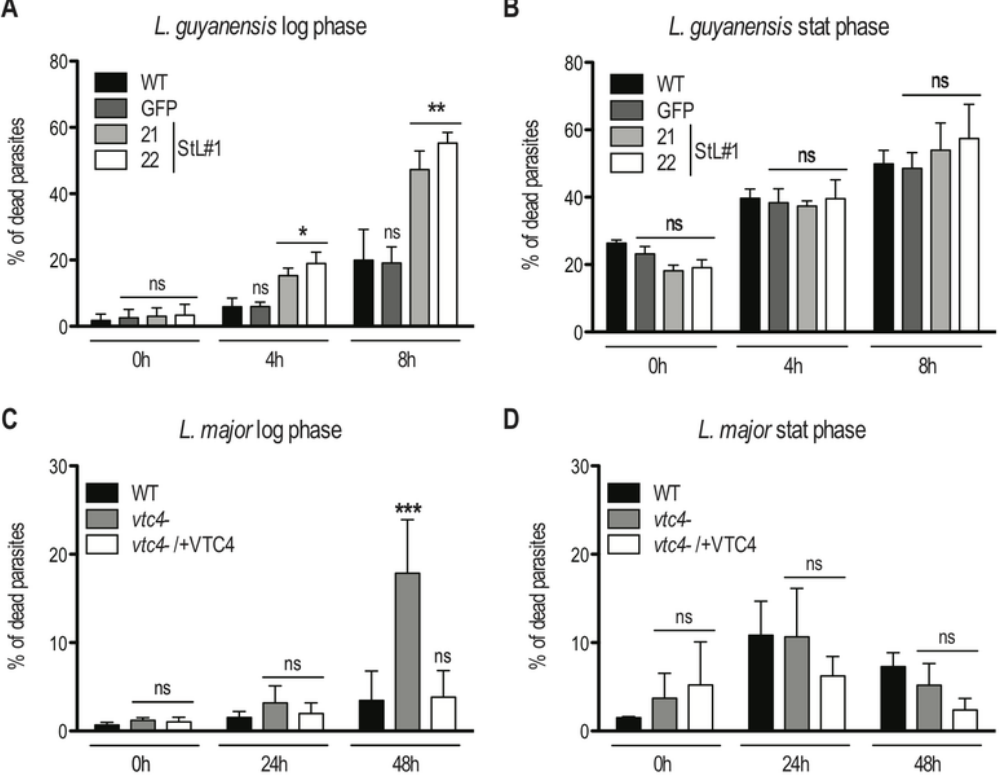
FIGURE 8: Lack of VTC4 and polyP results in increased cell death upon heat exposure. Logarithmic phase (day 3 post dilution) or stationary phase (day 6 post dilution) promastigotes of L. guyanensis (A and B) and L. major (C and D) were incubated at different temperatures (26°C and 37°C). The percentage of dead cells was assessed at the indicated time points by uptake of propidium iodide (PI). Results of a pool of 3 independ- ent experiments were expressed as mean ± SD. Statistical significance was assessed by Two-way ANOVA ( A - D ); * p < 0.05, ** p < 0.01, *** p < 0.001, ns: